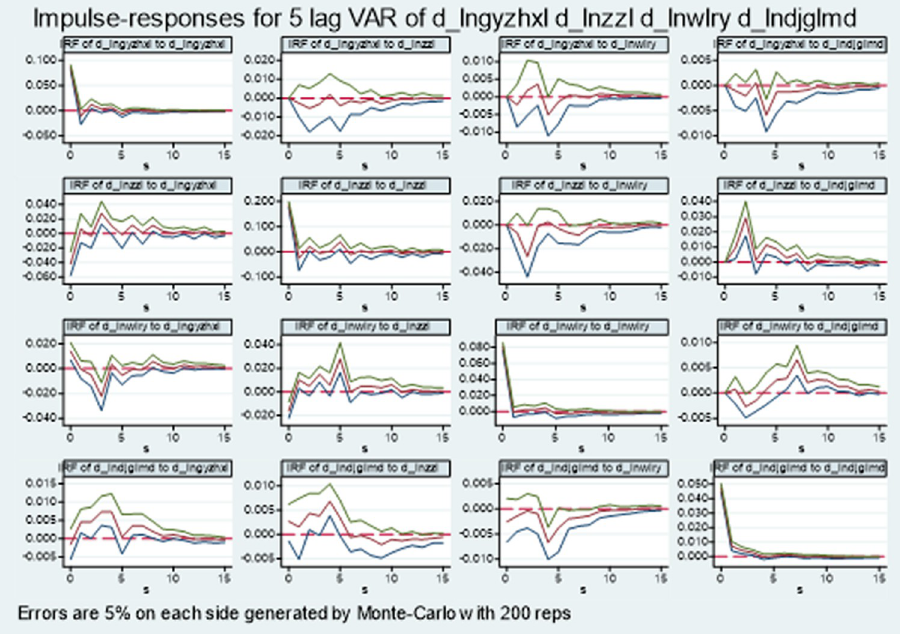
Fig 2. Impulse response diagram of coupling and coordinated development of two